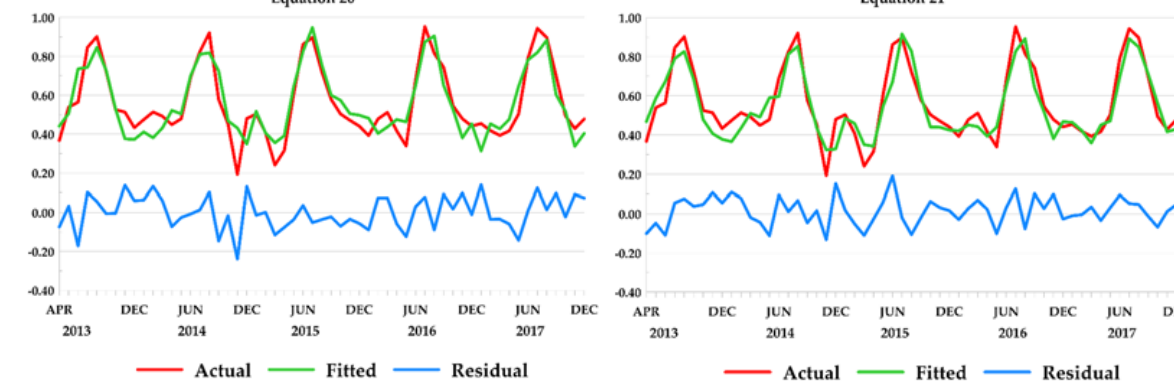
Figure 9. Representation for type 4 maize, estimation model and the residuals given by Equations (20) and (21). The forecast model is constructed as a combination of models presented in Equations (19)–(21). Therefore, the dynamic structure of the type 4 maize time series is included as the effect of average temperature, precipitation, average humidity and radia- tion. The combination of the models was obtained through least squares and mean squares, with a resulting MSE of 0.001 and 0.002, respectively. Figure 10 presents the forecast values for a one-year time horizon given by the estimation models presented in Equations (19)–(21) and least squares and mean squares aggregation models. The associated MSEs for each estimation model presented in Equations (19)–(21) were 0.004, 0.008 and 0.008. The best forecast model attending to the best MSE value was obtained by least squares.